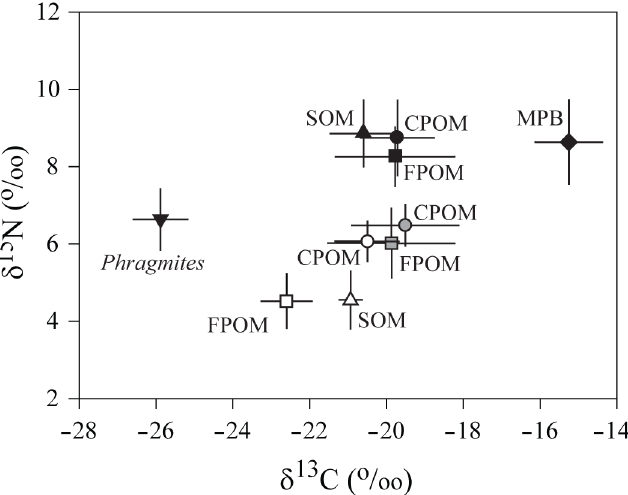
Fig 2. Mean of δ 13 C and δ 15 N values ( ± 1 SD) of suspended particulate organic matter (POM), sedimentary organic matter (SOM), microphytobenthos (MPB), and the common reed Phragmites australis . Black, gray, and white colors for POM and SOM represent the within-bay (Site S), the outer-bay (Site O), and offshore sites, respectively. FPOM, fine POM fraction < 20 μ m; CPOM, coarse POM fraction of 20 to 180 μ